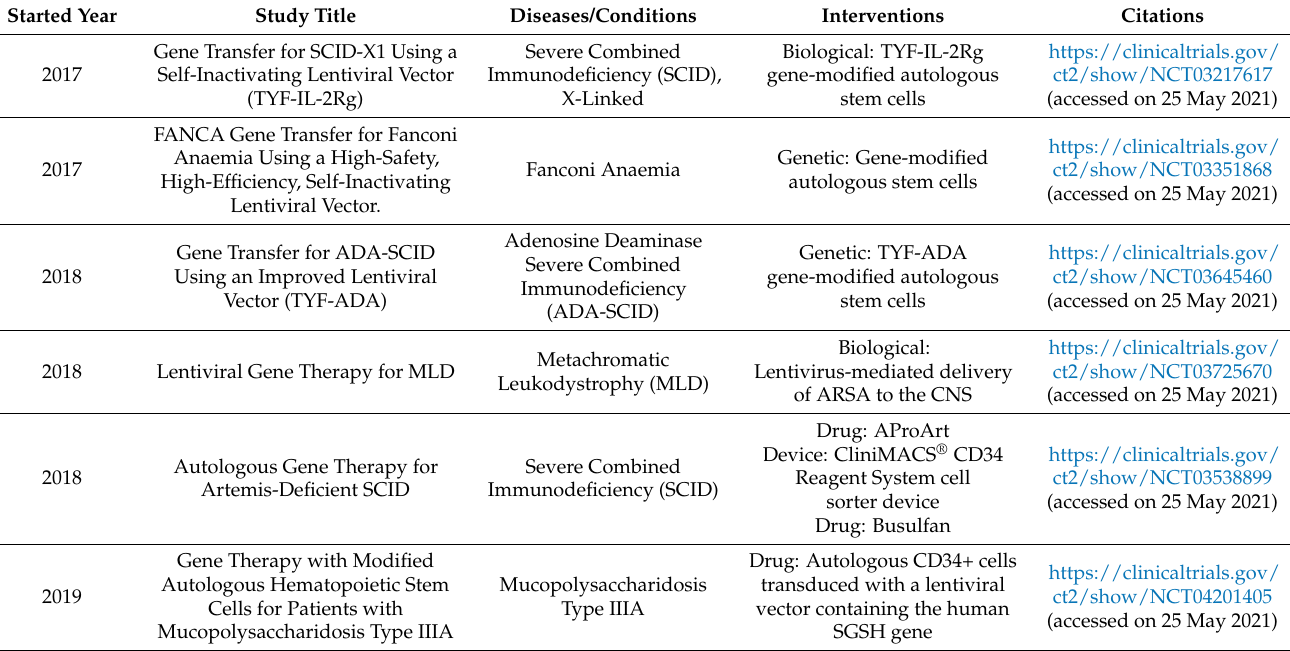
Table 2. The clinical trials conducted using self-inactivating lentiviral